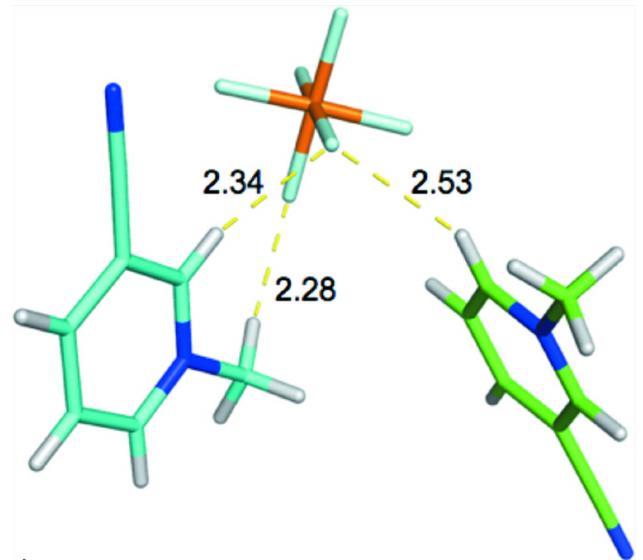
Figure 14 3-CMP + (cid:2)(cid:2)(cid:2) PF 6 (cid:3) interactions. BLYP-D3/def2-TZVP/SMD interaction energies (kcal mol (cid:3) 1 ) (cid:3) 17.8 for these complexes are: (green) and (cid:3) 16.6